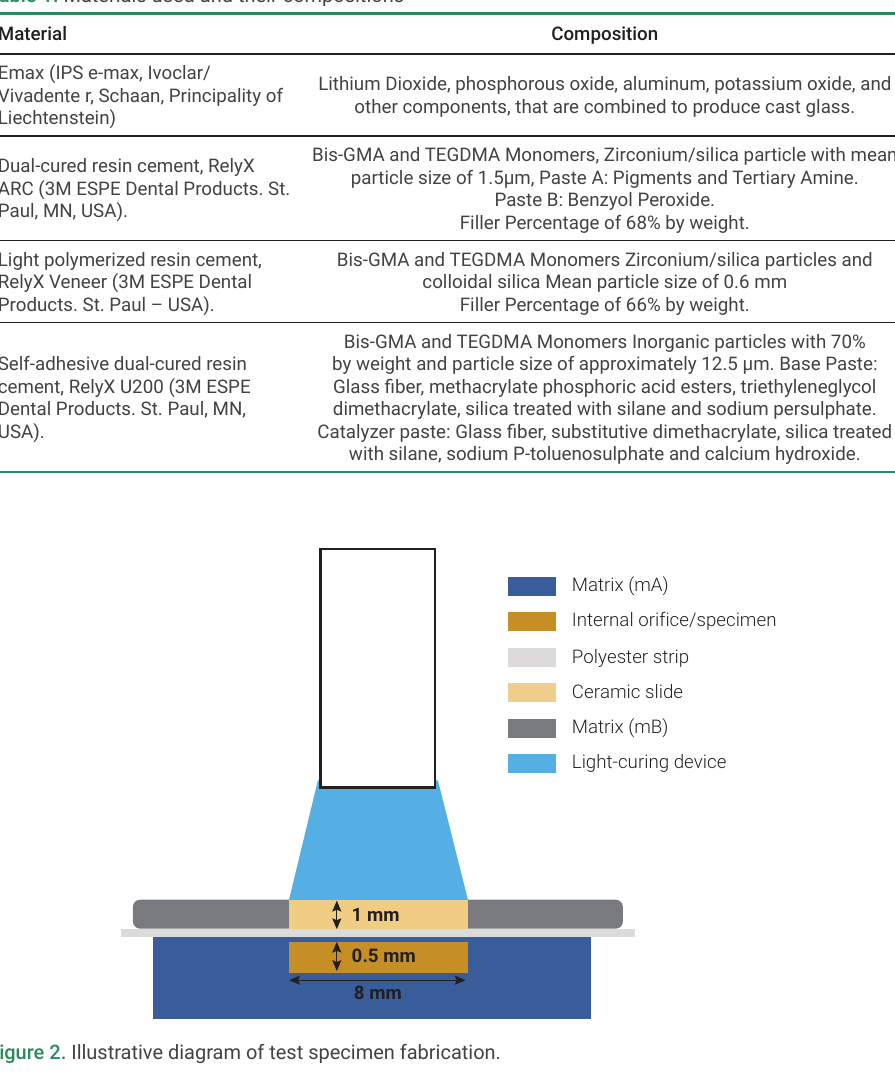
Table 1. Materials used and their